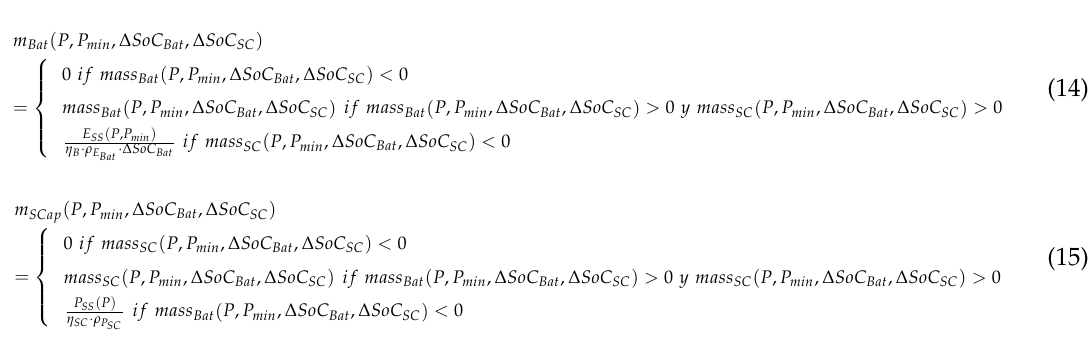
Figure 5. Equations system graphic solution in the fourth quadrant.